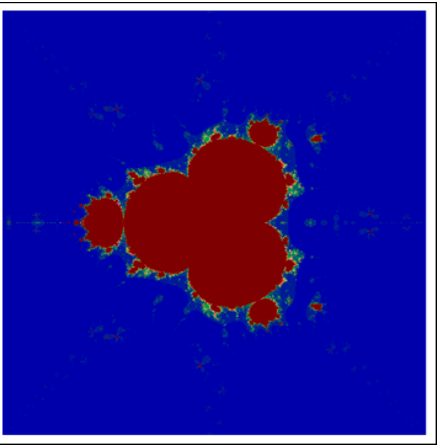
Figure 40. M-set via F-iterative scheme for sin ( z 4 ) + c with image visual time = 294.9